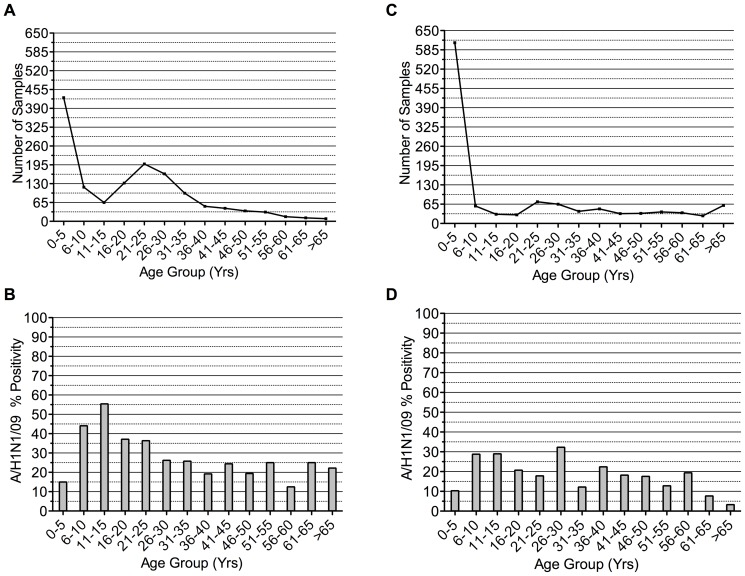
Age distribution of pandemic influenza among ILI and SARI cases.The figure represents the number of samples tested and positivity for A/H1N1/09 among different age groups A) Number of samples received from ILI cases B) Positivity among ILI cases C) Number of samples received from SARI cases D) Positivity among SARI cases.